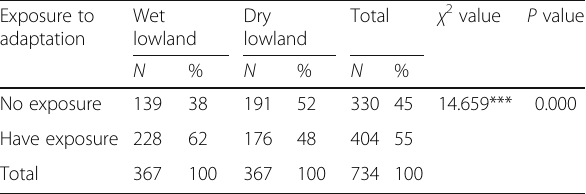
Table 3 Awareness of adaptation measures in the study area Exposure to